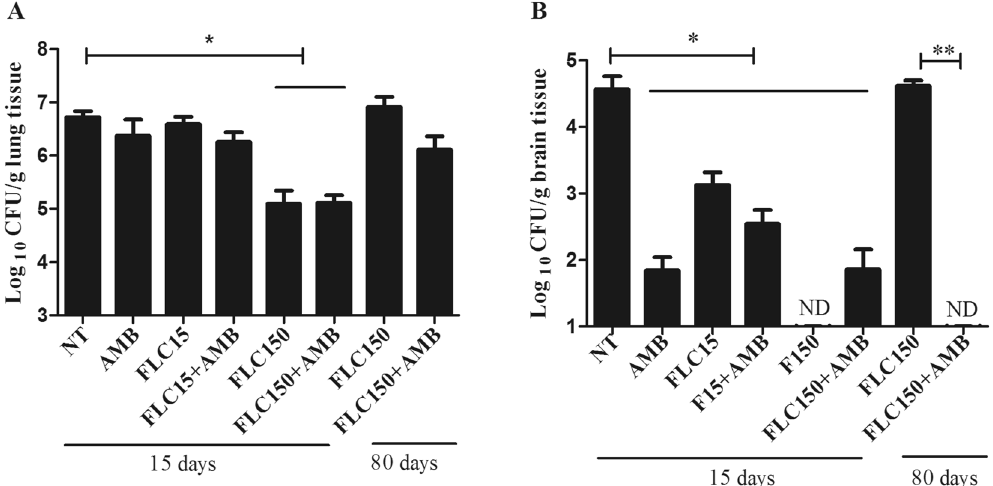
Figure 2. Mice were euthanized 15 or 80 days post-treatment. Lungs ( A ) and Brain ( B ) were removed and processed for measurement of fungal burden. Animals infected and treated with fluconazole 150 alone or in combination showed significant reduction of Log 10 CFU/g in the lungs, but no significant reduction of fungal burden in lungs occurred in other groups ( A ). NT (Control, untreated), AMB (Amphotericin B 0.5 mg/kg/day), FLC15 (Fluconazole 15 mg/kg/day), FLC150 (Fluconazole 150 mg/kg/day) FLC15 + AMB (Fluconazole 15 mg/ kg/day + Amphotericin B 0.5 mg/kg/day), FLC150 + AMB (Fluconazole 150 mg/kg/day + Amphotericin B 0.5 mg/kg/day), ND: not detected. * P < 0.05 ** P <